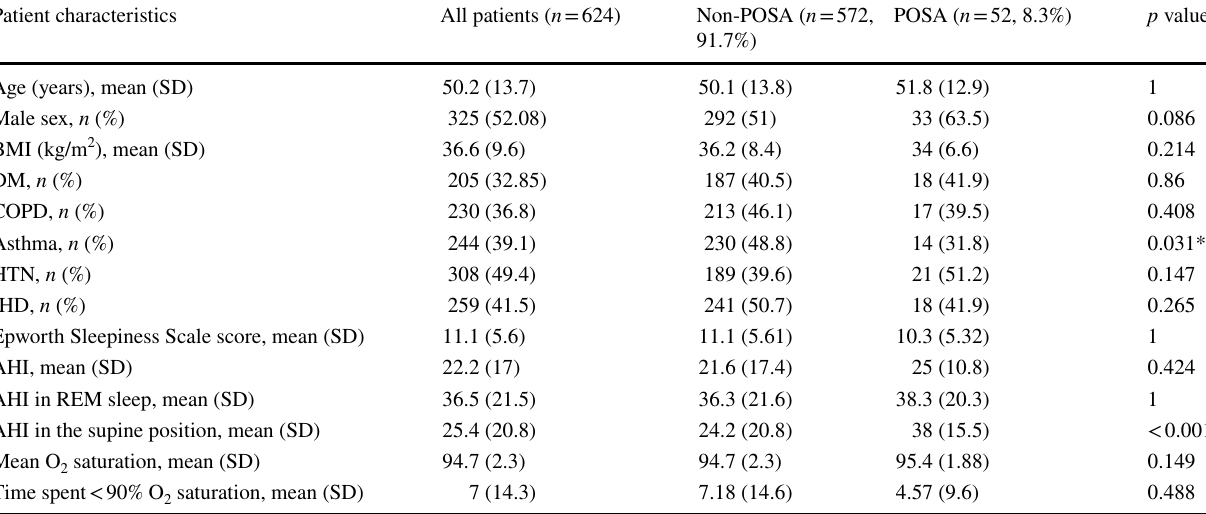
Table 6 General characteristics of patients classified according to POSA Definition 4